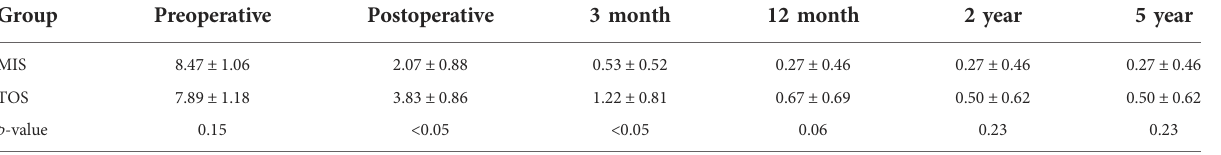
TABLE 4 VAS pain assessment of the two groups.